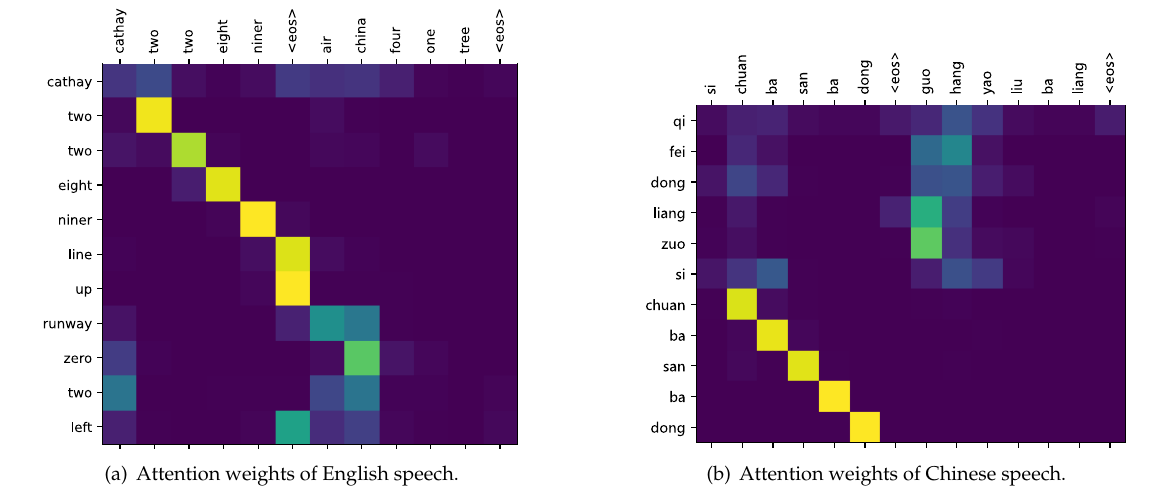
(a) Attention weights of English speech. (b) Attention weights of Chinese speech. Figure 3. The learned context attention weights of the CALM in the English word based rescoring procedure. Note that the Chinese characters in the ( b ) are represented by Chinese